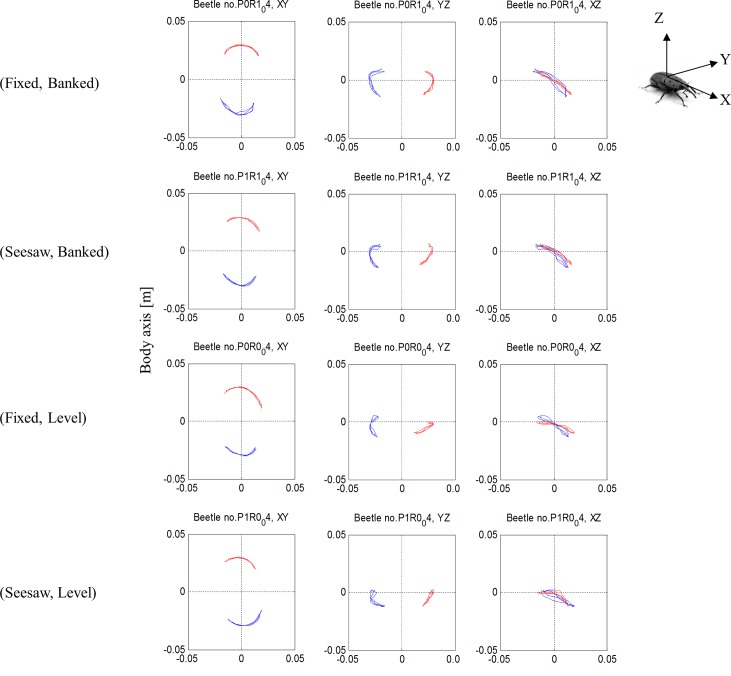
Wingtip trajectory in the body frame of reference during flight in the flight-mill.The rows present the four flights by the same beetle (beetle #4) in the four variants of the flight-mill. The trajectories of the left and right wingtips are denoted by red and blue color respectively. The left wing is the wing internal to the circular flight trajectory. Left, center, and right columns are the trajectory of the wingtips in the dorsal (XY), transverse (YZ), and sagittal (XZ) planes respectively, where X,Y,Z are the body axes defined in the insert on the right. The horizontal axis in each graph is the X, Y and X body axis and the vertical axis is the Y, Z and Z body axis in the left, center, and right column, respectively. The origin is always the base of the wing and all units are meters.